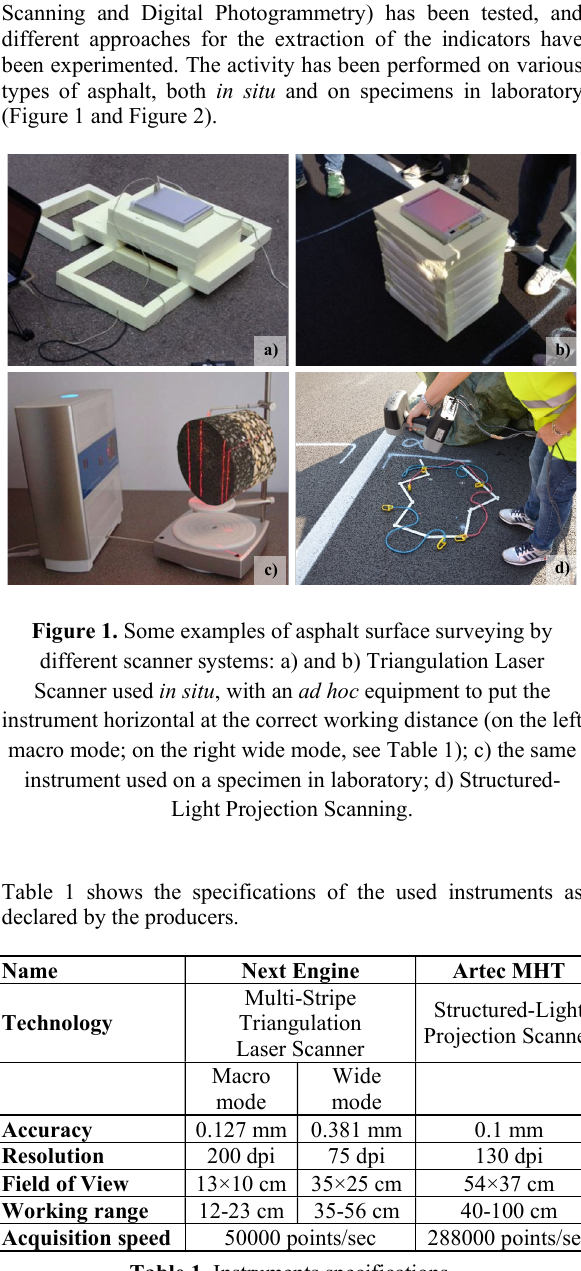
Figure 3. 3D models of the same asphalt area acquired in situ experimenting different surveying